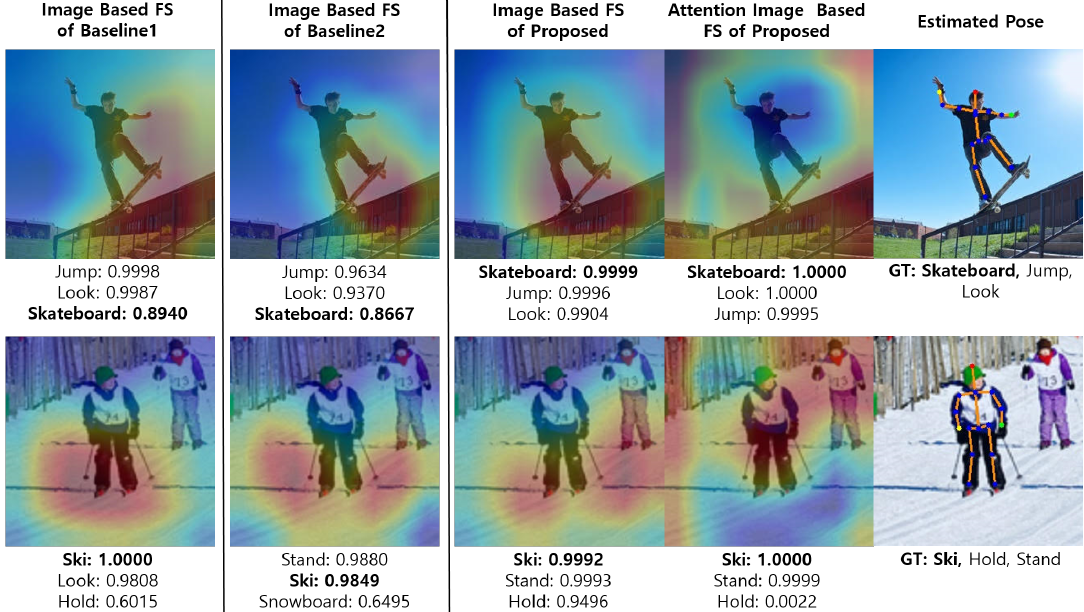
Figure 7. FS denotes Feature Stream. The first column depicts the results of the image-based feature stream on Baseline 1. The second column depicts the results of the image-based feature stream on Baseline 2. The third column depicts the results of the image-based feature stream with the proposed method. The fourth column depicts the results of the attention-image-based feature stream with the proposed method. The fifth column depicts the joints location from the pose estimation task. The results reported are on the V-COCO Dataset [16]. Class activation maps [43] comparison for the bold GTs (“Skateboard” in first row and “Ski” in second